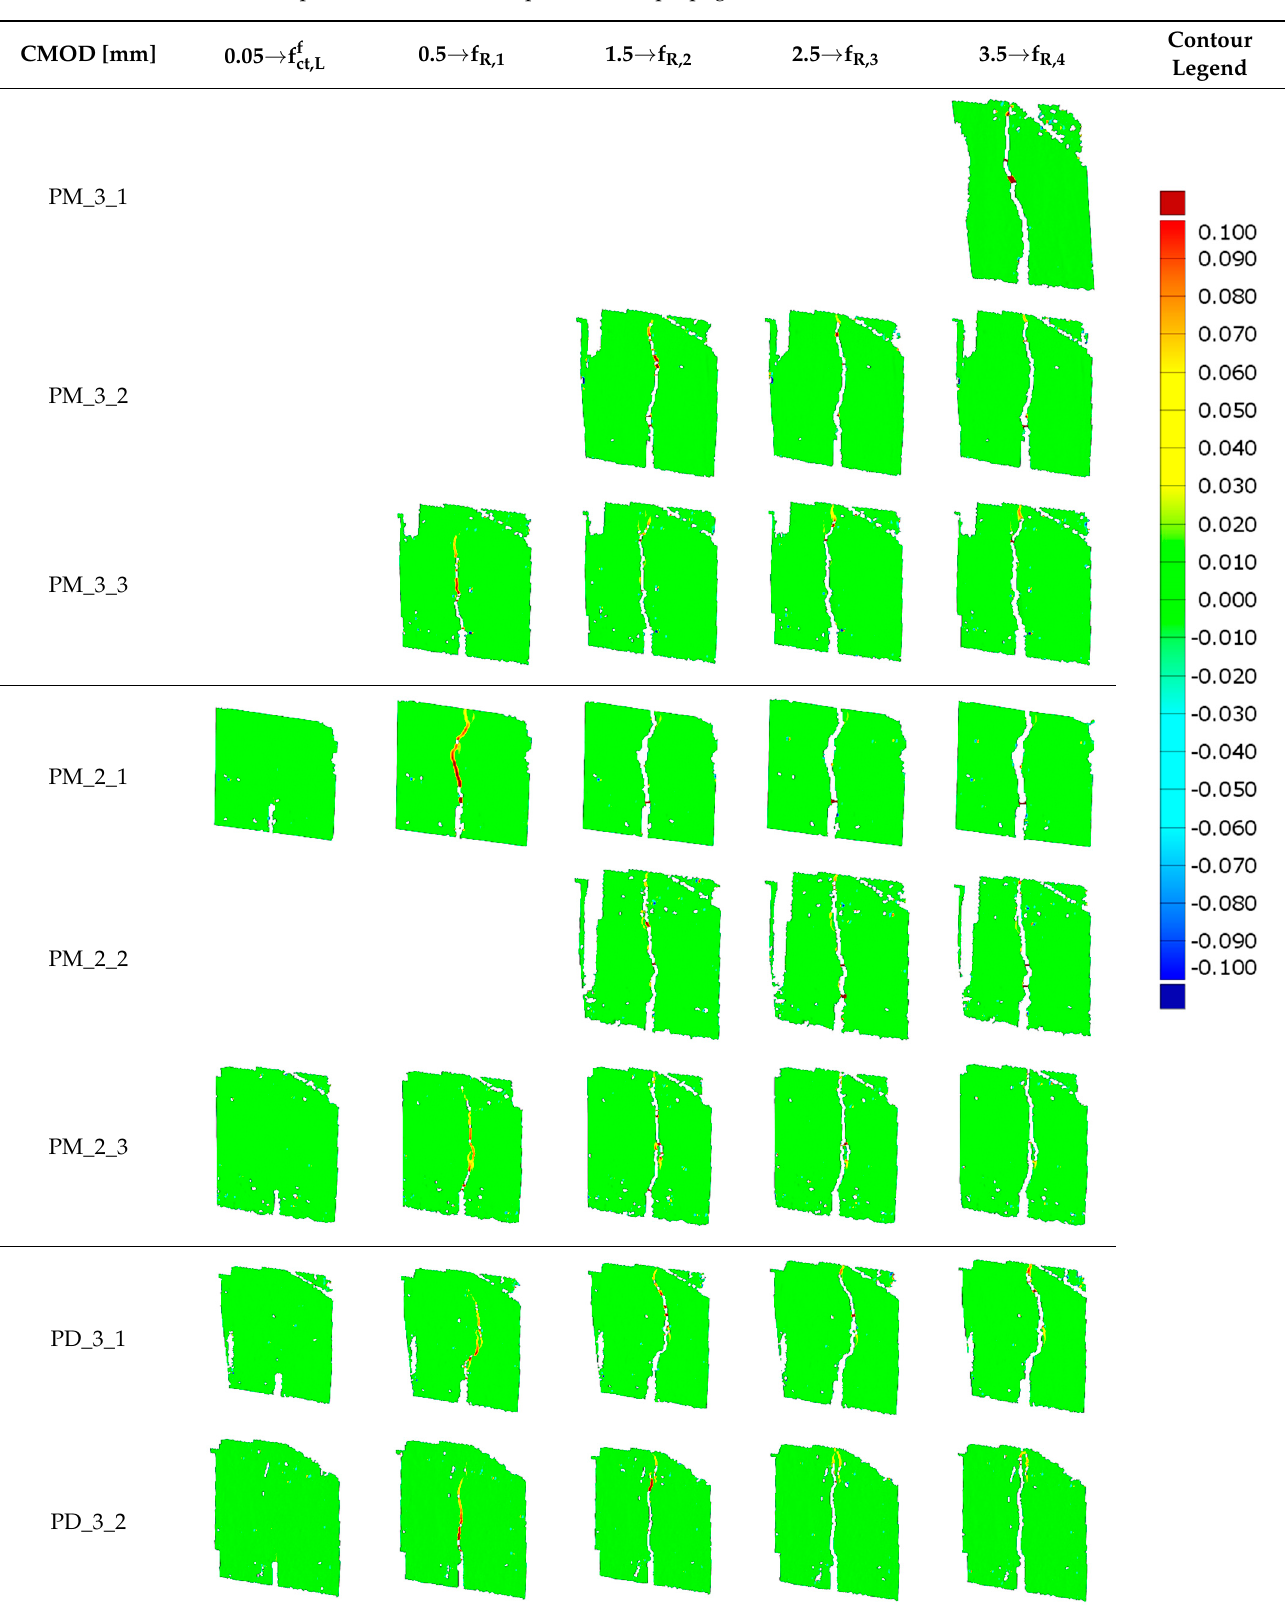
Table 14. Comparison of ε x strain maps and crack propagation in FRC beams at considered CMOD.